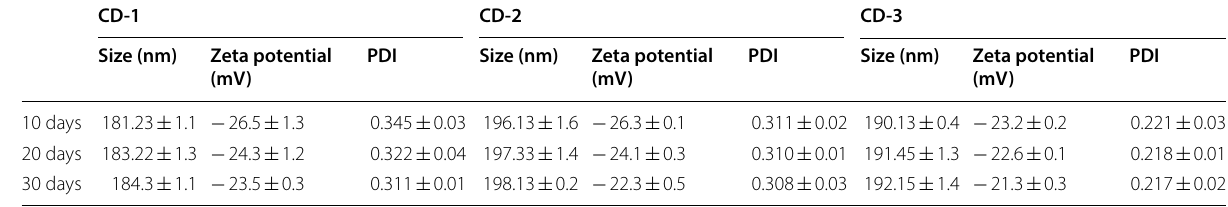
Table 3 Size, zeta potential and PDI of CD-1, CD-2 & CD-3 after 10, 20 and 30 days during stability